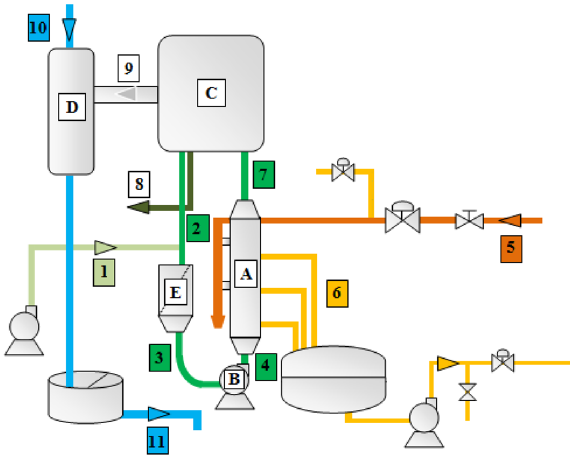
Figure 1. Schematic drawing of the phosphoric acid concentration